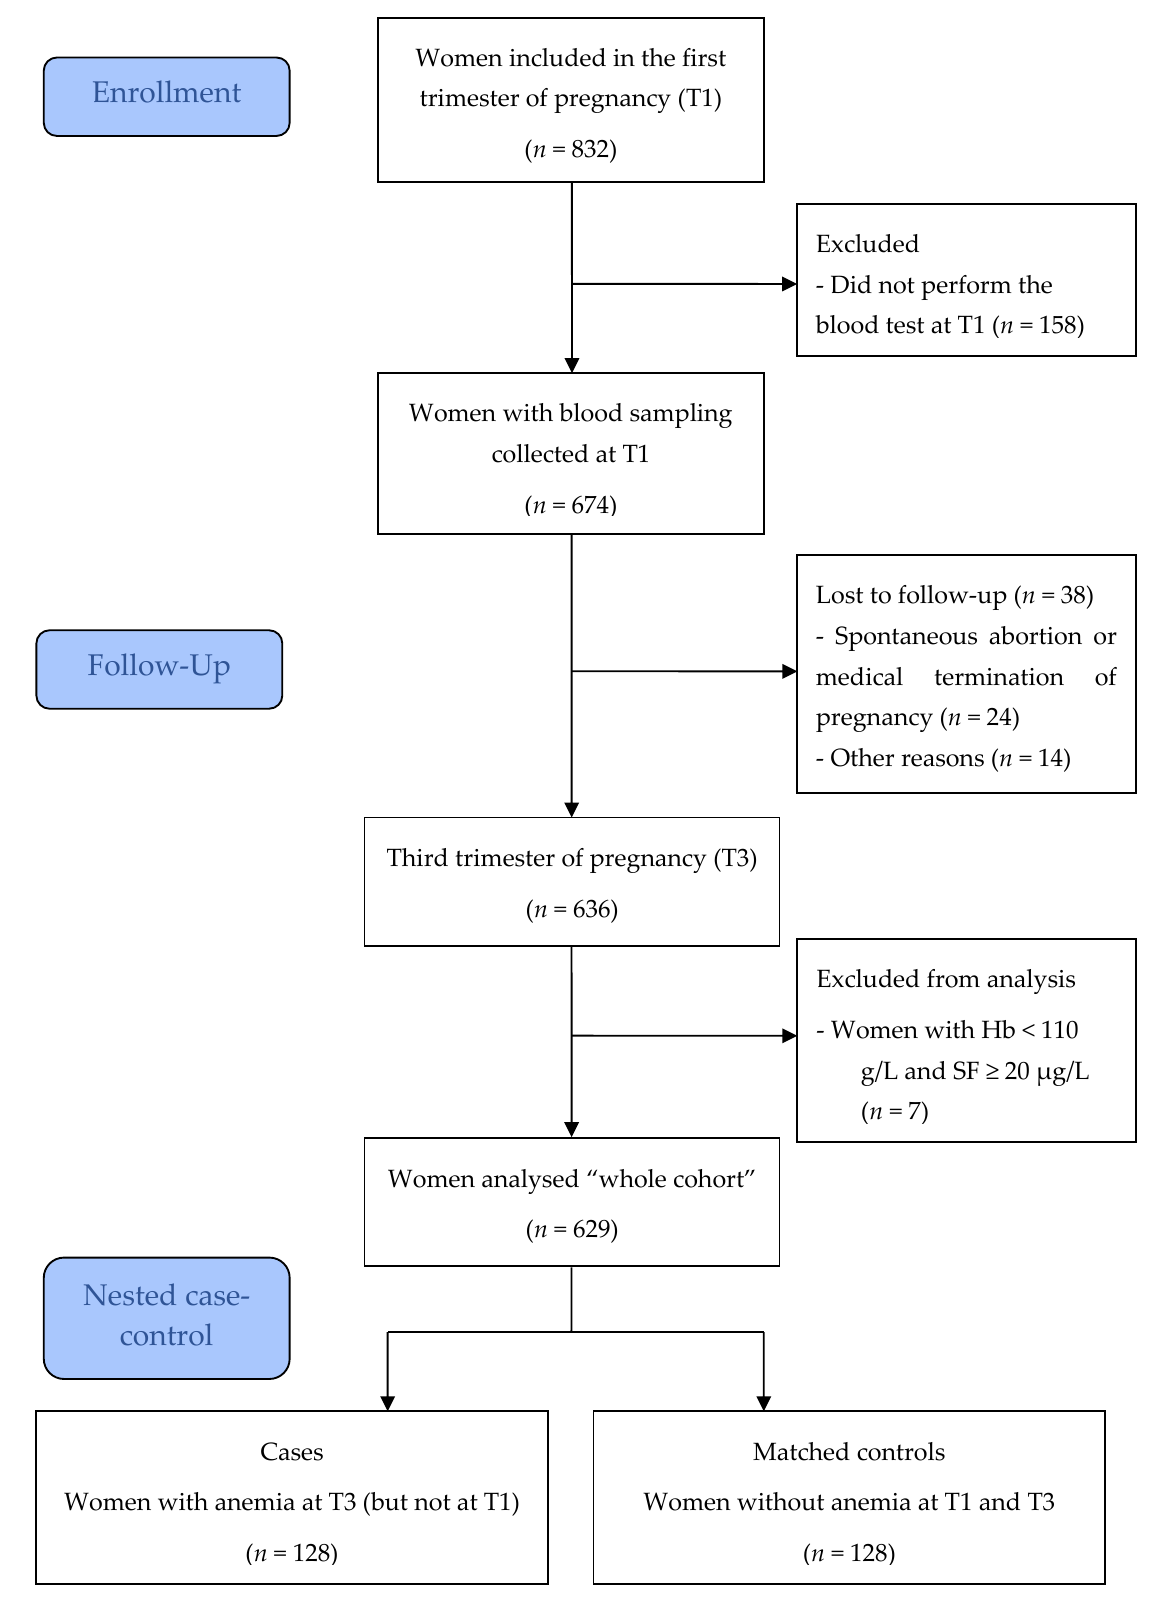
Figure 1. Flow diagram of